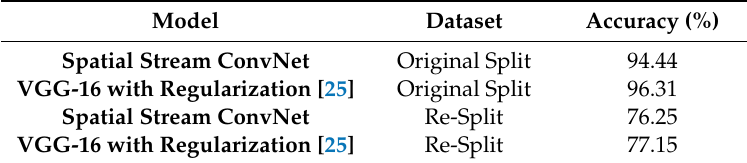
Table 1. Performance evaluation and comparison for spatial stream ConvNet in the AUC Distracted Driver Dataset.